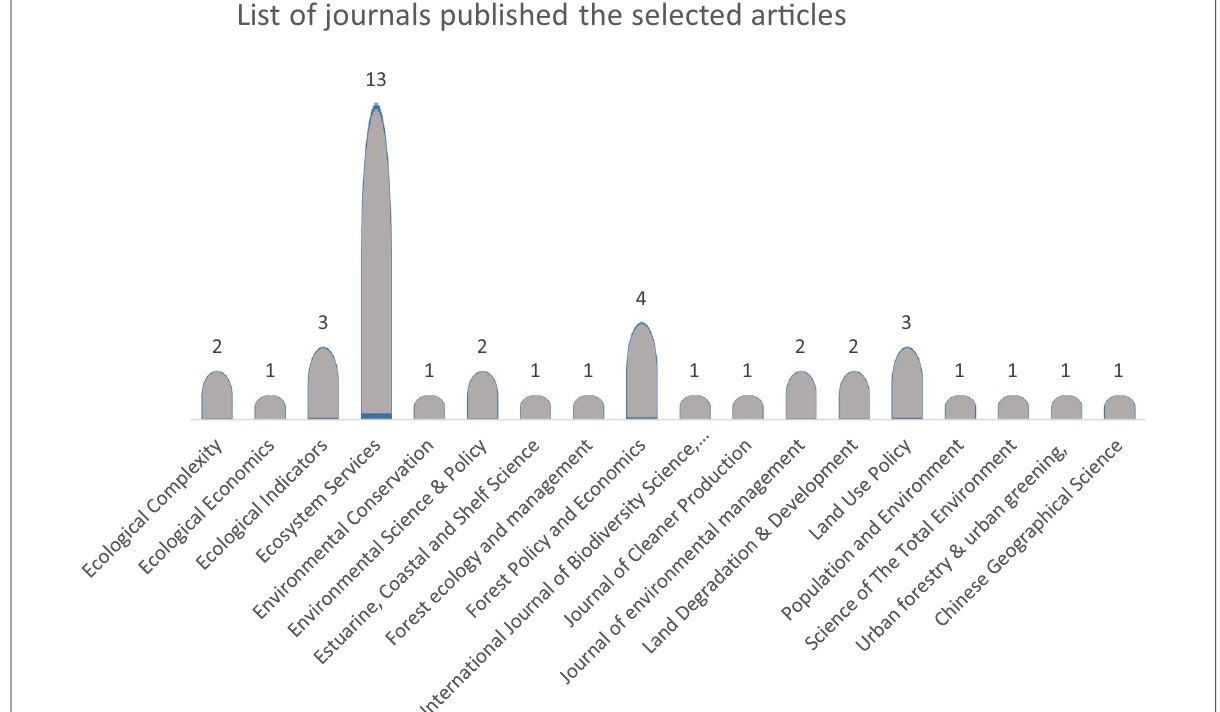
Fig. 7 List of journals that published selected publication used for further analysis. It includes journal types that published the articles selected for final analysis using the selection criteria. The total number was 18 journal types and 10 of them got published only one article and one journal (ecosystem services) alone published 13 articles out of